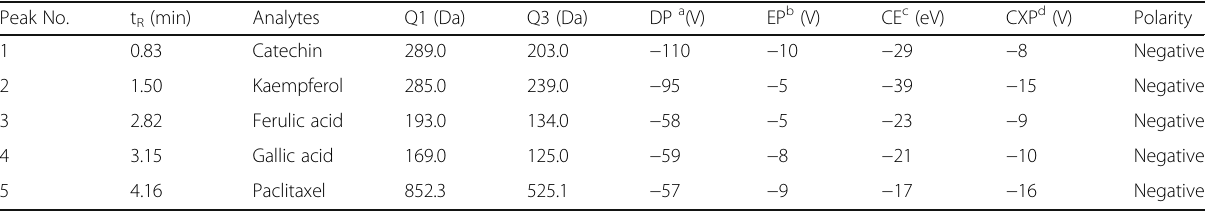
Table 1 Multiple reaction monitoring (MRM) compound dependent parameters for reference analytes Peak